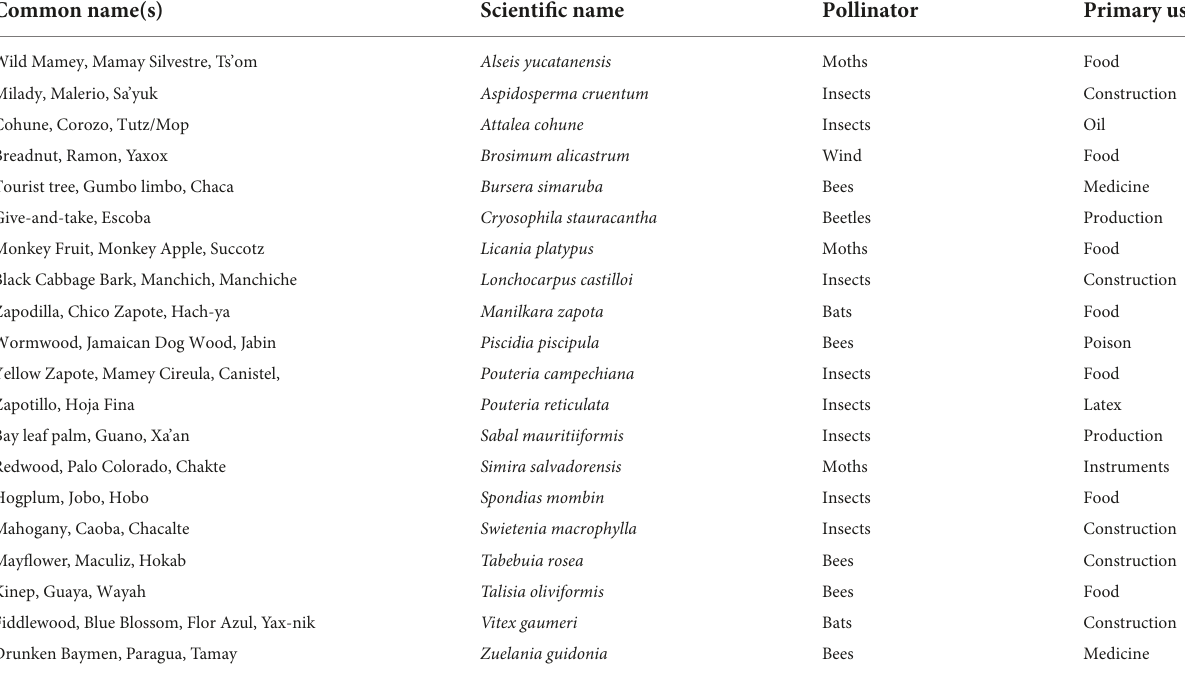
TABLE 1 The top 20 dominant plants of the Maya